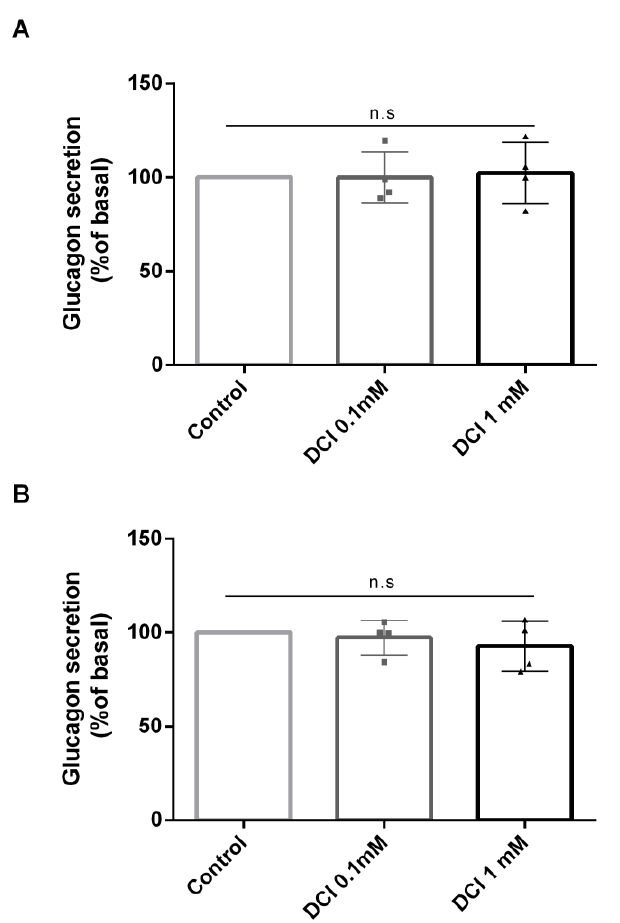
Figure 2. E ff ect of DCI on glucagon secretion in α -TC1-6 cells. Glucagon secretion in cells treated with DCI (0.1 or 1 mM) for 48 h in control conditions (without palmitate). ( A ) Acute glucagon levels secreted by α -cells cultured in the presence or absence of DCI; glucagon levels were detected after 48 h of treatment in 2 h cell-conditioned Krebs–Ringer bu ff er (KRB) (control: 1505 pg / mg protein ± 12 vs. DCI 0.1 mM: 1504 pg / mg protein ± 12 vs. DCI 1 mM: 1539 pg / mg protein ± 13). ( B ) Chronic glucagon levels, detected directly in Dulbecco’s modified Eagle’s medium (DMEM) at the end of 48 h of treatment in cells cultured in the presence or absence of DCI in control conditions, without palmitate (control: 1825 pg / mg protein ± 14 vs. DCI 0.1 mM: 1774 pg / mg protein ± 9 vs. DCI 1 mM: 1694 pg / mg protein ± 12). Data represent four independent experiments. One-way ANOVA followed by Bonferroni test ( n = 4) was used to evaluate statistical significance in DCI treated cells with respect to controls. n.s., not significant; DCI, D-chiro-inositol.